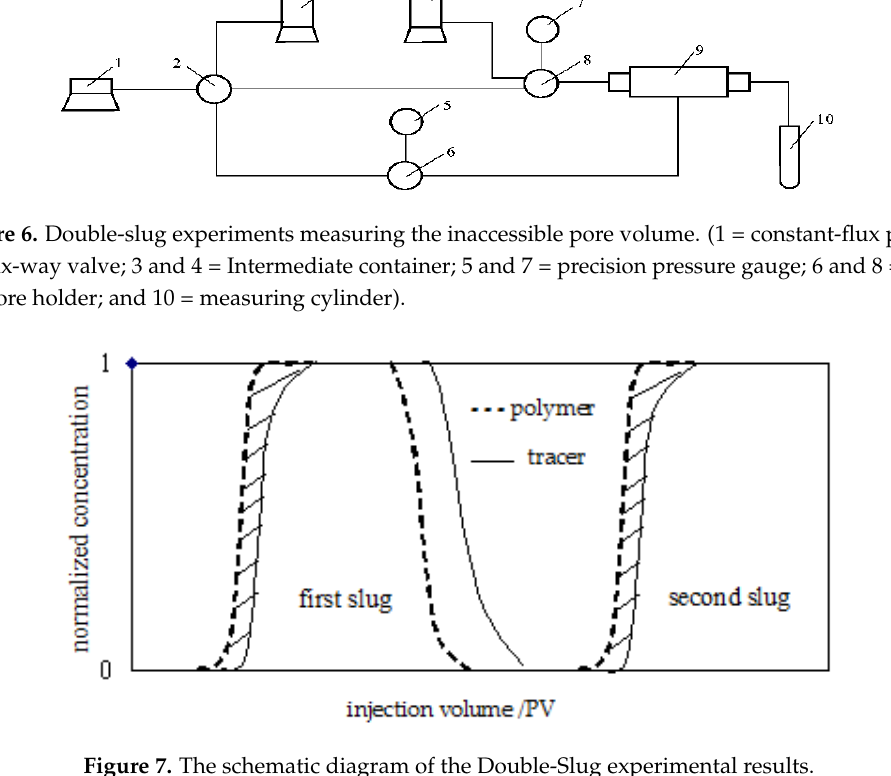
Table 5. The results of the three parallel core experiment.